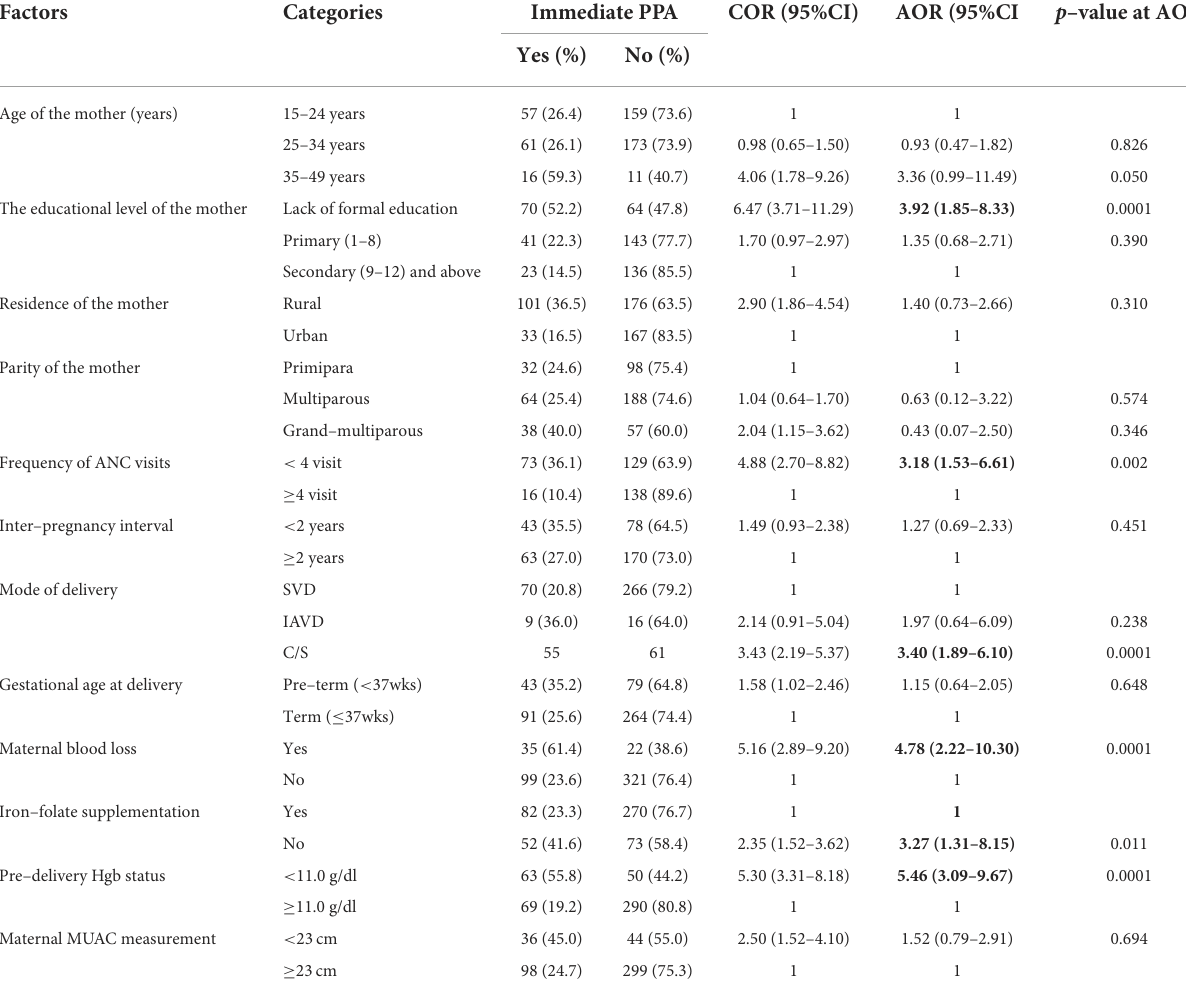
TABLE 4 Bi-variable and multivariable analysis of factors associated with immediate postpartum anemia among postpartum women admitted to the maternity ward in public hospitals in Harari Regional State, Eastern Ethiopia, 2021 (N = 477).